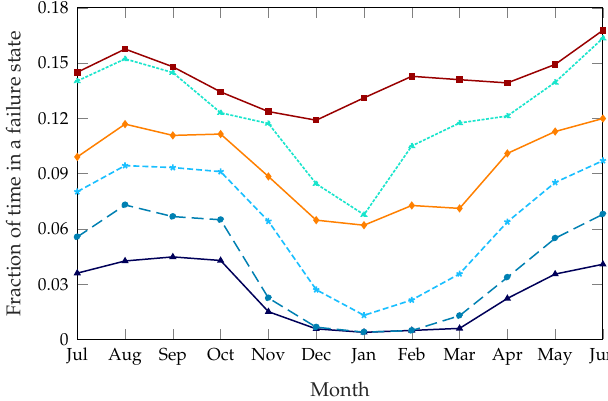
Figure 3. Monthly average probability of being in a failure state, over a year.